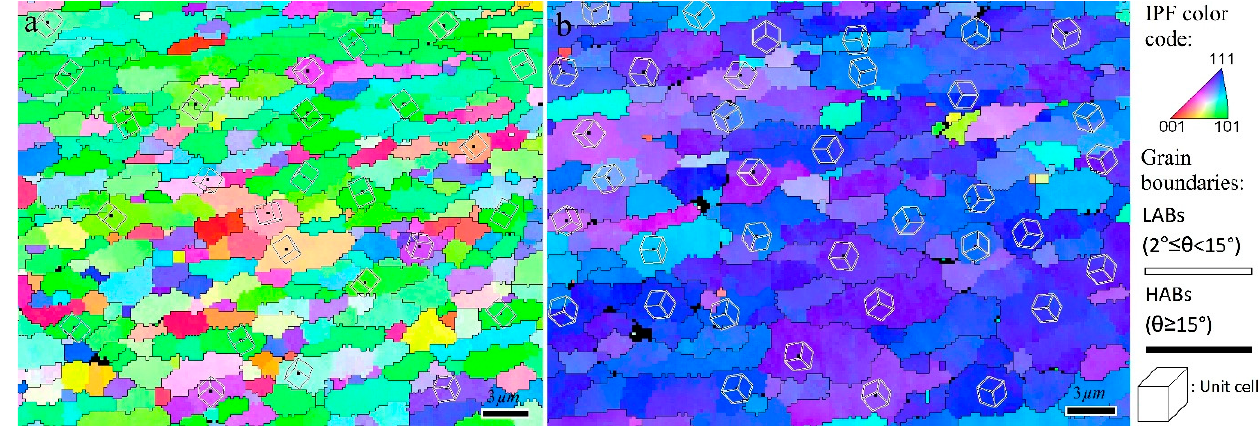
Figure 17. Inverse pole figure maps of SZ-I ( a ) and SZ-II ( b ) after applied rotations for texture analysis. The drawn cubes refer to the orientation of unit cells in individual grains.